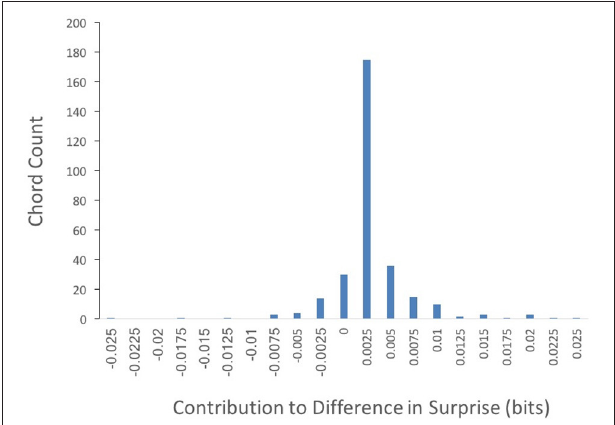
FIGURE 4 | Frequency of Q1 chords by their contribution to the surprise difference between Q1 and Q4 (Equation 3, with κ set to “whole song”). The majority of chord types contribute to the superiority in surprise of Q1